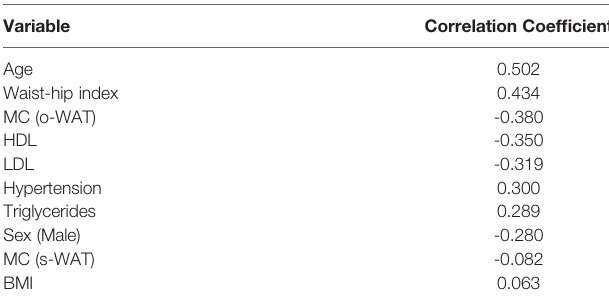
TABLE 4 | Correlation of LD1 with the